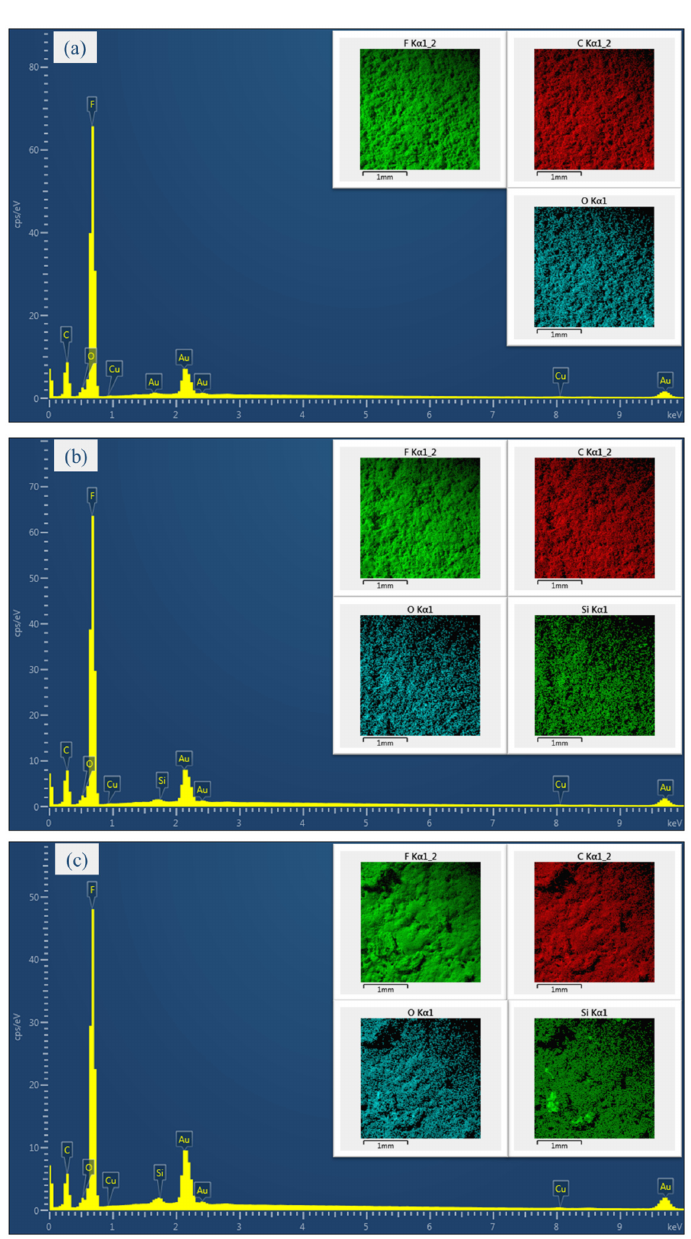
Figure 4. Typical X-ray spectrum and element maps of the electro-sprayed materials ( a ) sample T/C; ( b ) sample T/AG; ( c ) sample T/C/AP.